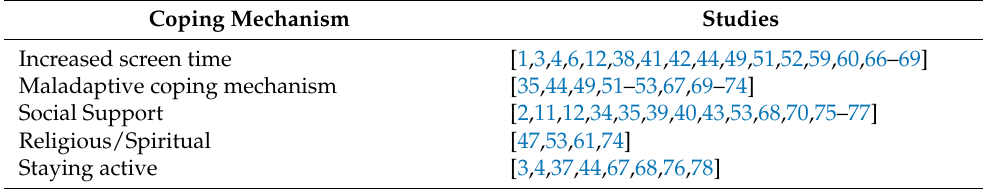
Table 3. Summary of studies on the coping mechanisms adopted by students. Coping Mechanism Studies Increased screen time Maladaptive coping